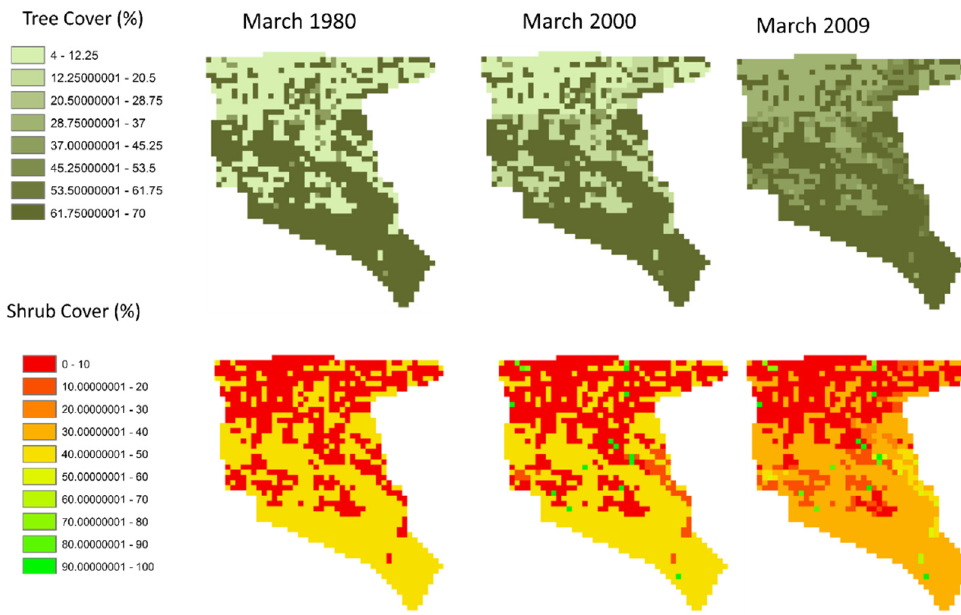
Figure 12. A comparison of the spatial distribution of tree and shrub cover for 1980, 2000 and 2009. Appl. Sci. 2020 , 10 , x FOR PEER REVIEW